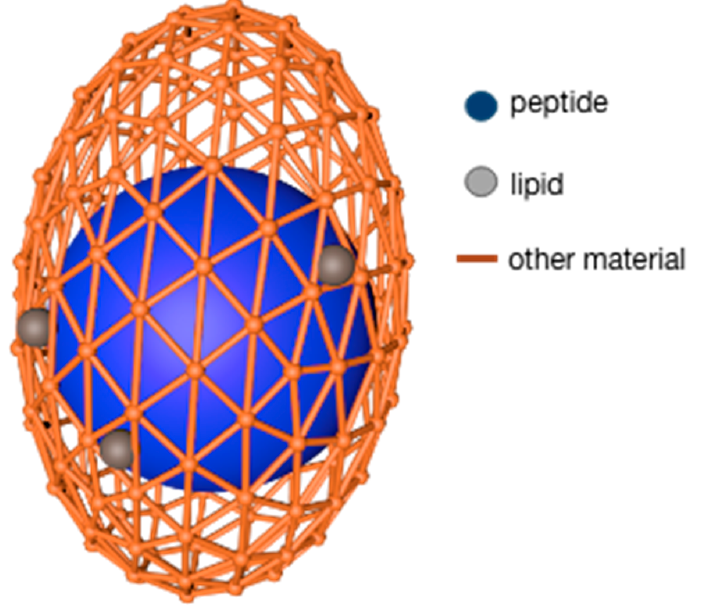
Figure 1. Microcapsule wall materials of alginate filled by